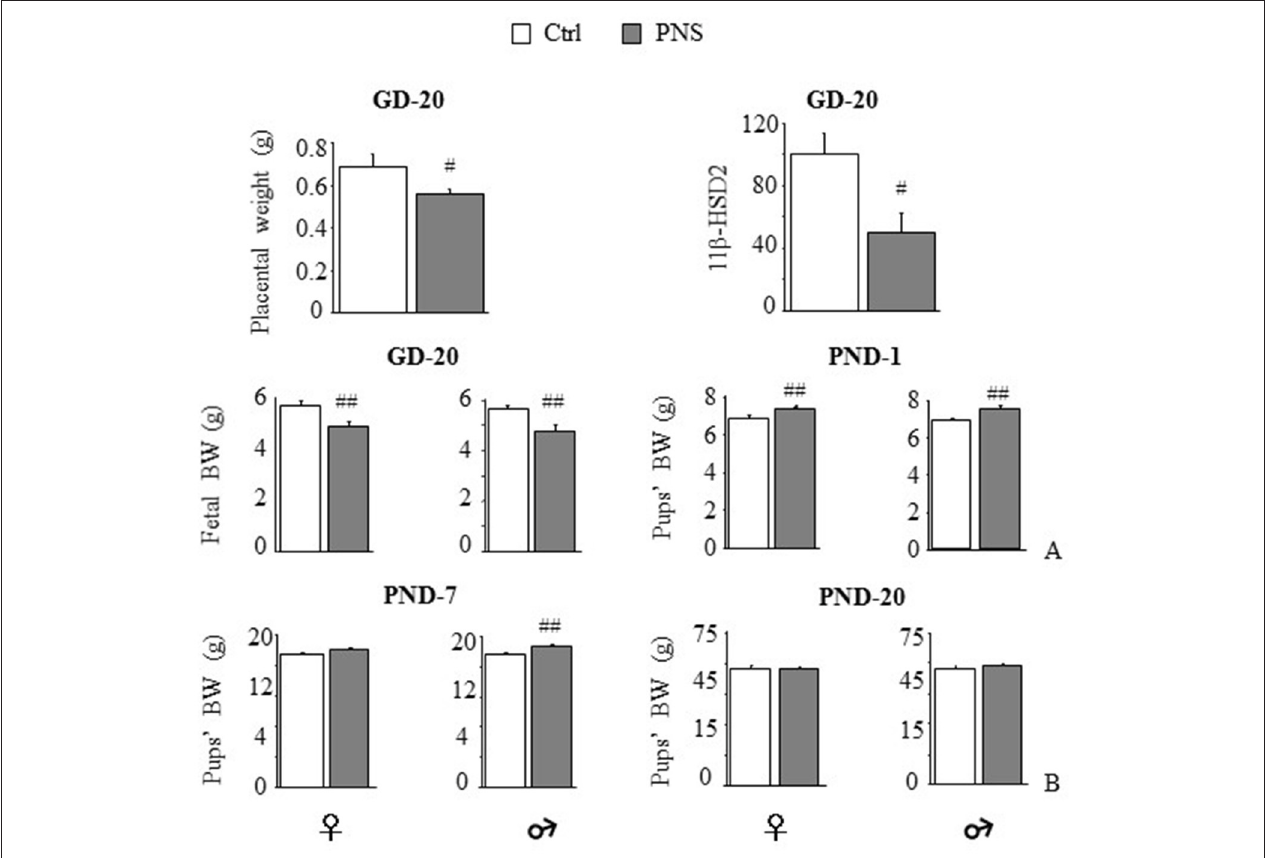
FIGURE 1 | Short-term effects of prenatal stress (PNS) on the placenta and on body weight. PNS reduced placental weight and mRNA expression of the placental barrier enzyme 11 β -HSD2 . (A) PNS reduced fetal body weight (BW) on gestational day (GD) 20; on postnatal day (PND) 1 PNS increased BW in both female and male offspring. (B) This effect is maintained on PND-7 only in males while differences in BW disappeared on PND-20. Data are shown as mean + SEM; # p < 0.05, ## p < 0.01, main effect of Prenatal